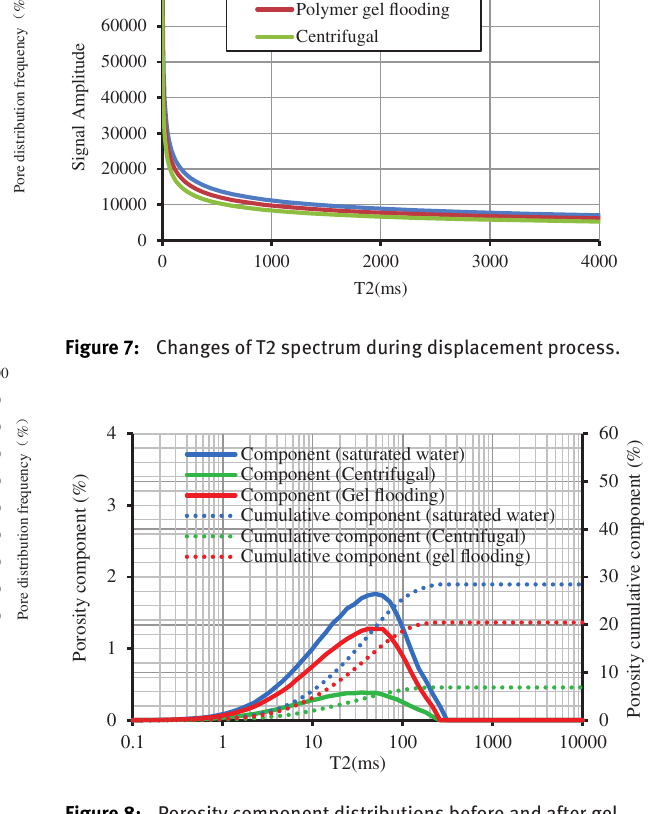
Figure 6: Distribution frequency of pore radius.